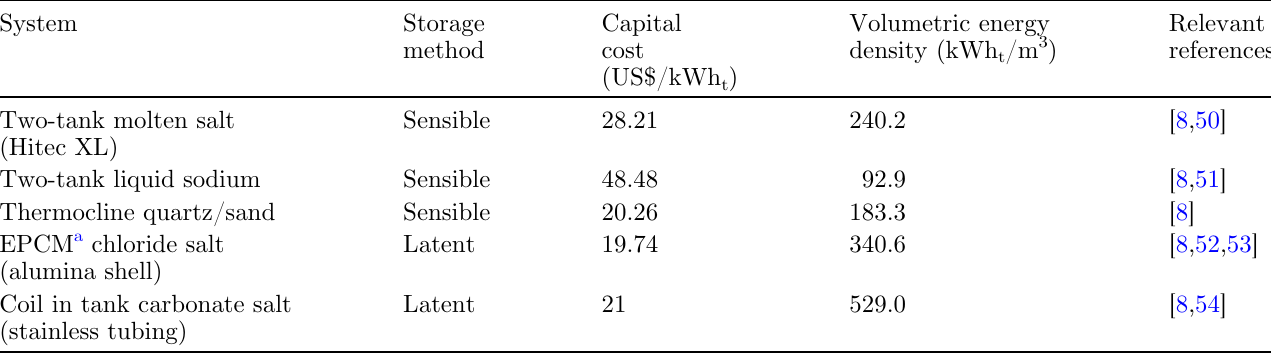
Fig. 3. Comparison of the typical cost breakdown for a MGA (a) and molten salt (b) thermal storage deployments. Table 3. Cost and energy density of state of the art TES